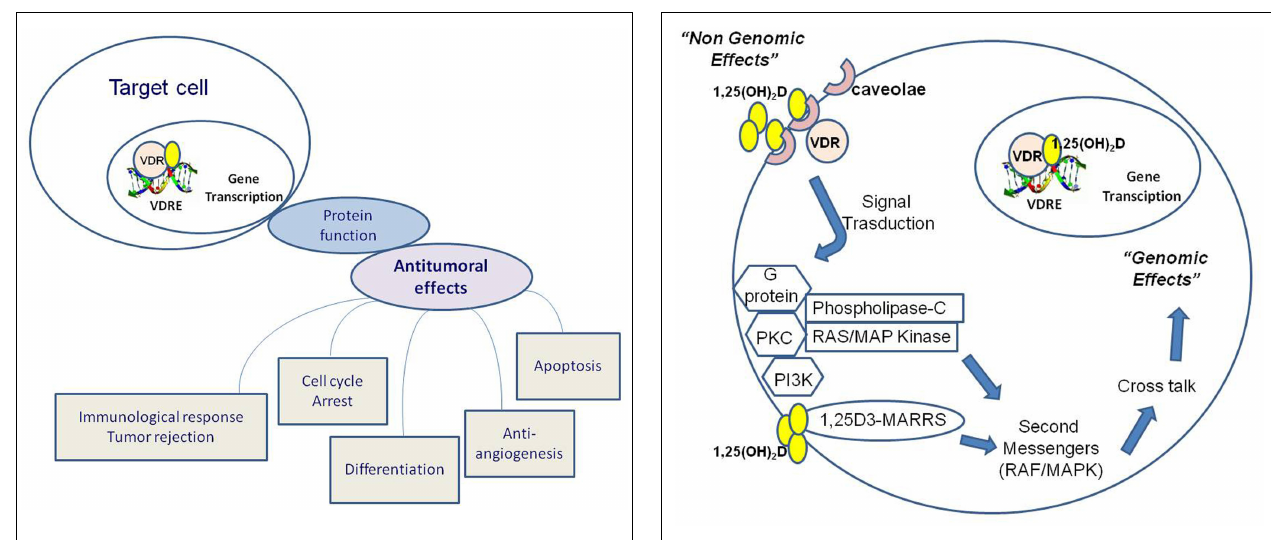
FIGURE 3 | 1,25(OH)2D operates through nuclear receptor-mediated and plasma membrane-initiated mechanisms. 1,25(OH)2D interacts with the vitamin D receptor (VDR) localized in the cell nucleus to generate genomic effects or in caveolae of the plasma membrane to generate non-genomic effects (rapid responses, RR). Moreover, 1,25(OH)2D can directly interact with a novel receptor for 1,25(OH)2D called 1,25D3-MARRS (membrane-associated, rapid response steroid-binding). Binding of 1,25(OH)2D at plasma membrane may activate one or more second messenger systems, including phospholipase C (PKC), protein kinase C, G protein-coupled receptors, or phosphatidylinositol-3-kinase (PI3K). Possible outcomes include opening of the voltage-gated calcium or chloride channels or generation of second messengers. Some of these second messengers, particularly RAF/MAPK, may modulate a cross-talk with the nucleus for gene expression